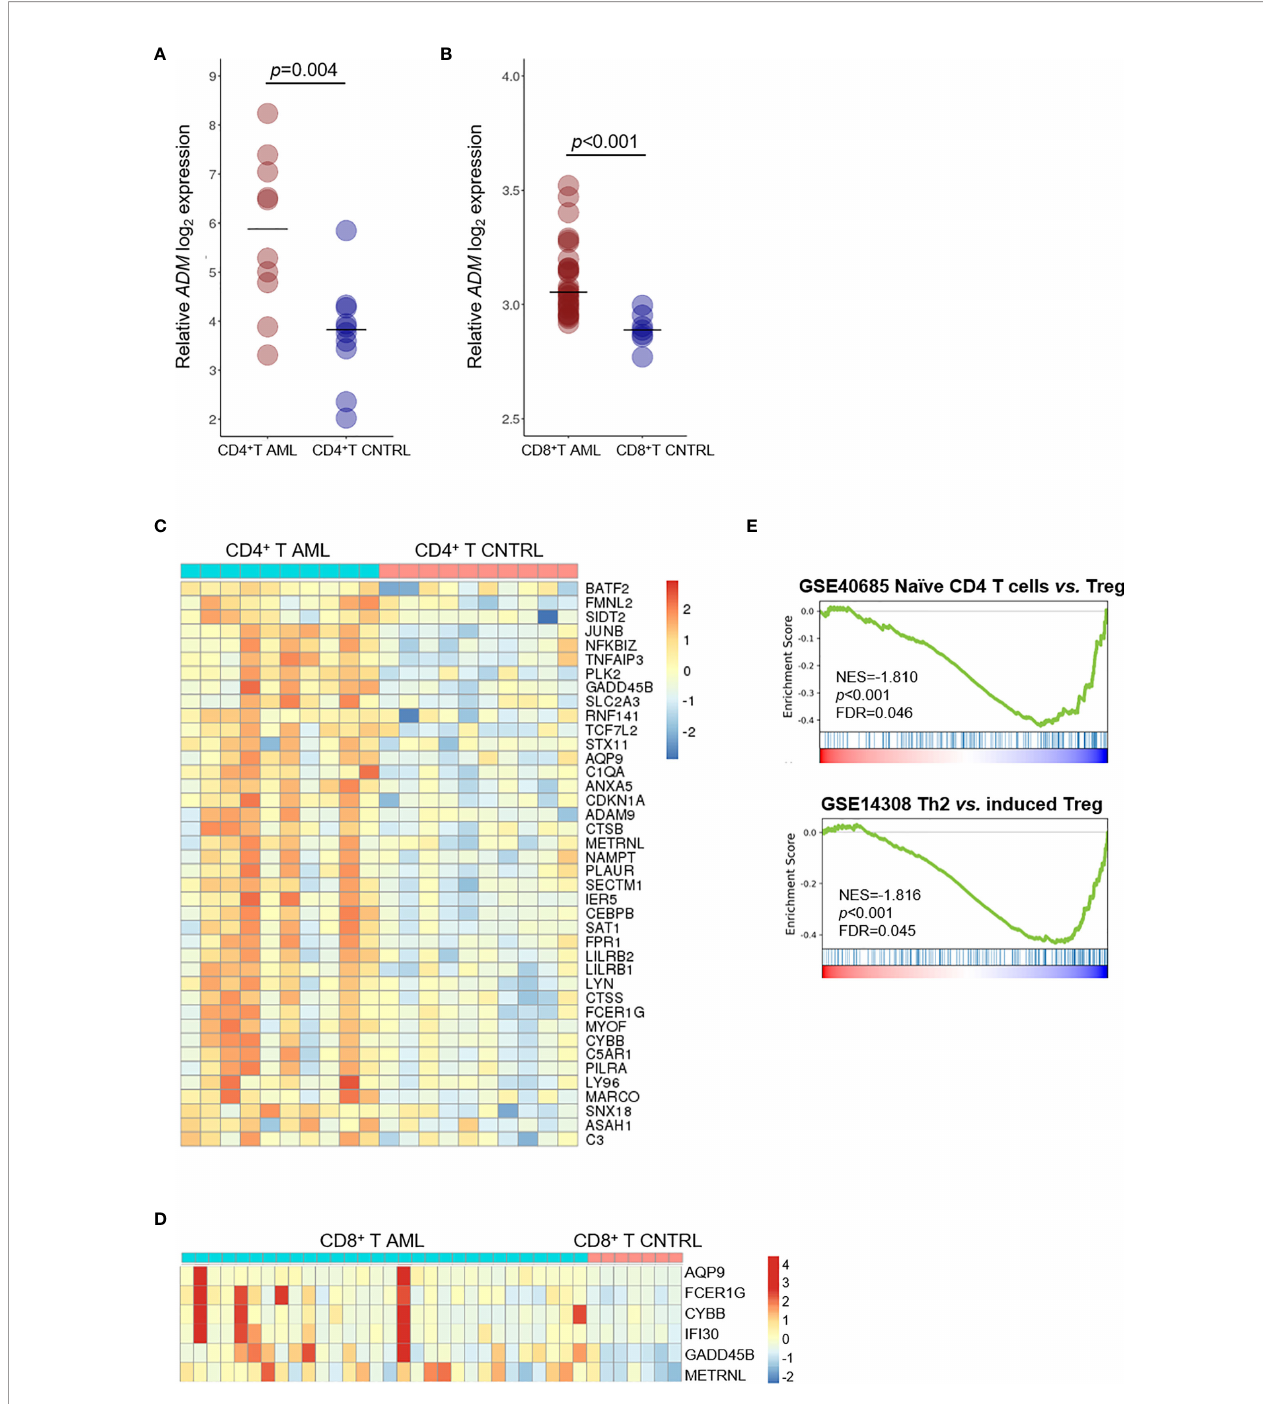
FIGURE 5 | ADM is overexpressed in the T cell compartment of AML patients and associates with a tolerogenic gene signature. (A) Comparison of ADM levels between CD4 + T cells from AML patients and healthy subjects (GSE14924) and (B) between CD8 + T cells from AML patients and healthy subjects (GSE117090). Scatter plots were generated with the R package ggplot2 (48) (version 3.3.1). Each dot indicates one sample and the bar represents the median value (CNTRL: healthy subjects). (C) Heatmap of ADM co-expressed genes that are differentially expressed between CD4 + or (D) CD8 + T lymphocytes isolated from AML patients and from healthy subjects. Columns represent patients/subjects. Data were standardized through a z-score transformation. Color changes within a row indicate expression levels relative to the mean and rescaled on the transcript standard deviation. Genes are grouped according to average linkage hierarchical clustering. Heatmaps were built with R package pheatmap (64) (version 1.0.12). (E) GSEA of CD4 + T cells from AML patients compared with healthy subjects showing the enrichment of tolerance signatures (NES, normalized enrichment score, FDR, false discovery rate; Th2, T-helper 2, Treg, regulatory T